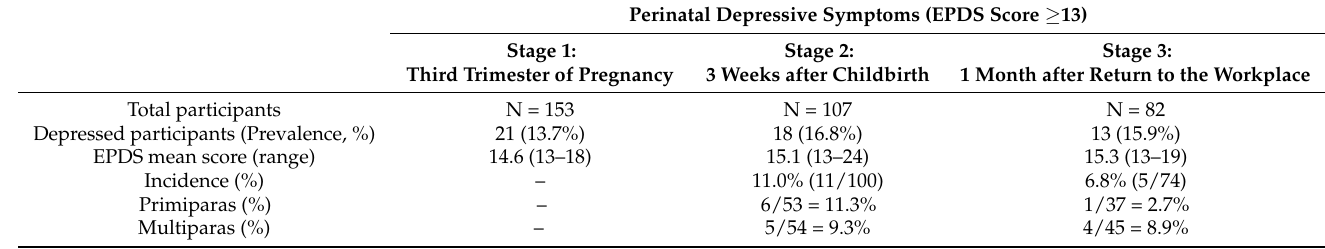
Table 2. Period prevalence and incidence of perinatal depressive symptoms in the third trimester of pregnancy, at 3 weeks after childbirth, and at 1 month after returning to work. Perinatal Depressive Symptoms (EPDS Score ≥ 13) Stage 1: Stage 2: Third Trimester of Pregnancy 3 Weeks after